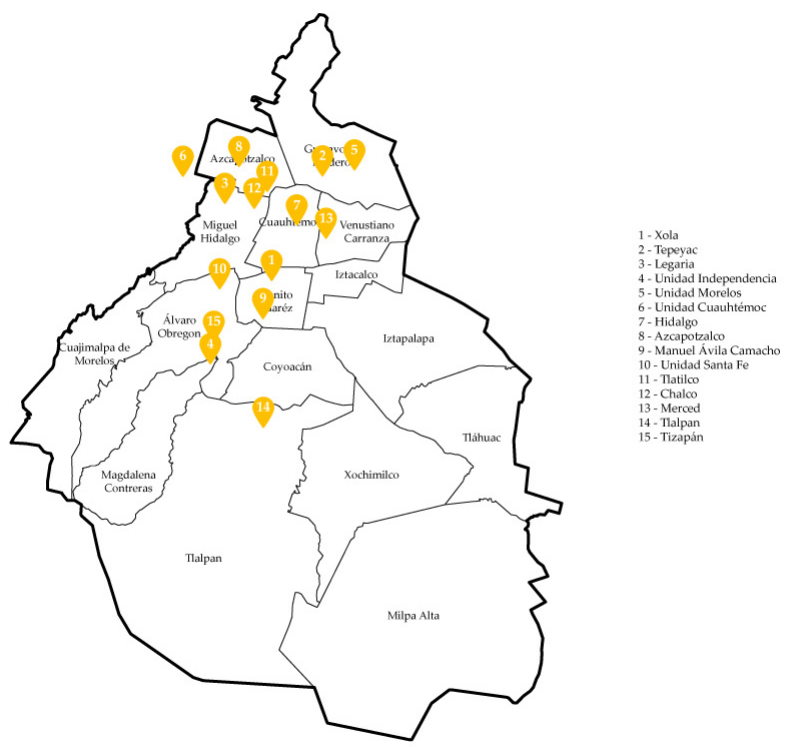
Figure 4. Location of the Casas de la Asegurada in Mexico City between 1960 and 1971 according to [18]. Source: Drawing by Laura Iturralde Compeán, 2021.